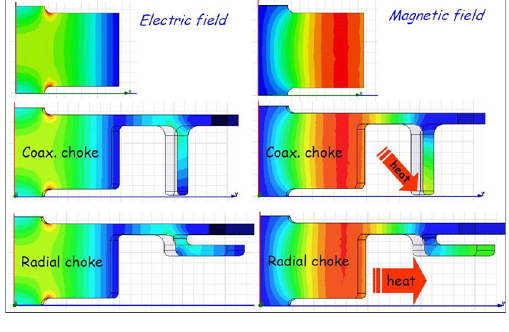
FIG. 4. Radial choke